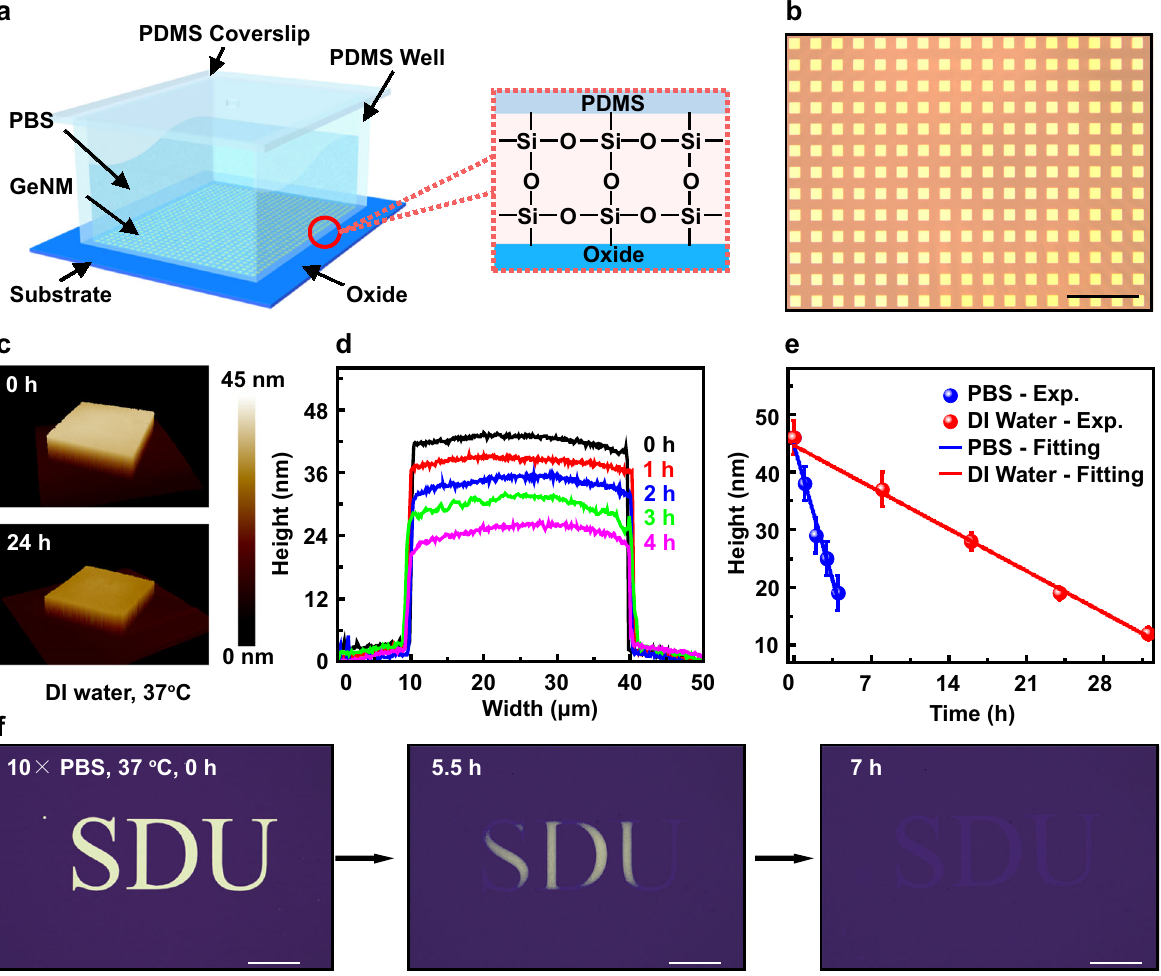
Fig. 2 Dissolution of germanium nanomembranes. a Schematic diagram of the key components and materials for testing the dissolution behaviors of germanium nanomembranes. The right highlights the chemical bonds between UV-ozone-treated PDMS and silicon dioxide. b Optical microscope image of a germanium relief array, which is formed directly on a GOI wafer. Scale bar is 200 μ m. c AFM images of a typical germanium relief, with a dimension of 30 × 30 μ m, at different dissolution periods (top: 0 h; bottom: 24 h) in DI water (37 °C). d AFM pro fi les of a typical germanium relief at different dissolution periods in 10× PBS (pH = 7.4, 37 o C). e Experimental (symbols) and fi tted (lines) changes in thickness varying with dissolution time for germanium nanomembranes soaked in 10× PBS (pH = 7.4, 37 o C, blue) and DI water (37 °C, red). Error bars indicate standard deviations. f Optical microscope images of germanium nanomembrane-based “ SDU ” logo at different dissolution time frames. Scale bar is 100 μ